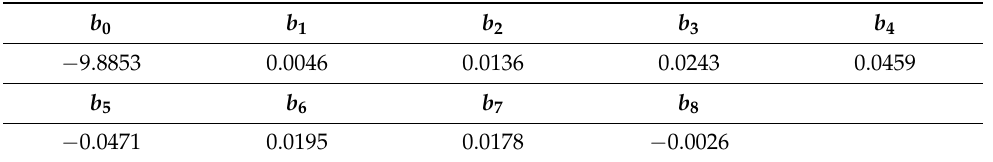
Table 1. Resulting slope coefficients of the multiple linear regression including the AS7341’s channels F1–F8 for the complete data